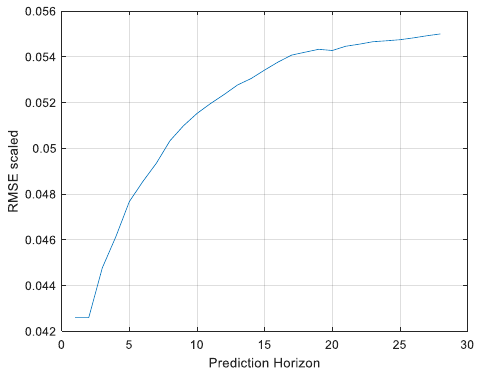
Figure 19. Evolution of RMSE over the prediction horizon — M 4 .